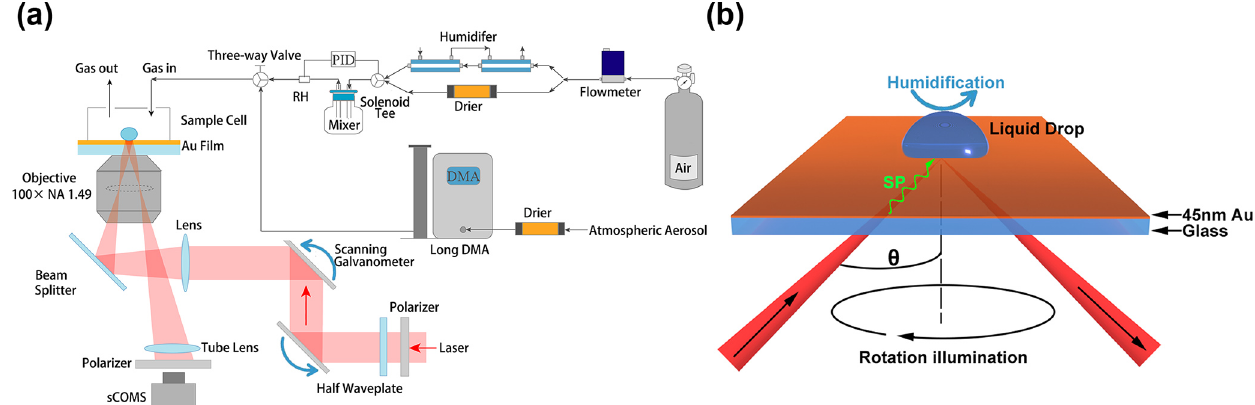
Figure 1. Schematic diagram of the SPRM-ARI single nanoparticle moisture absorption system: (a) for the complete system setup and (b) for the gold-coated glass substrate used for